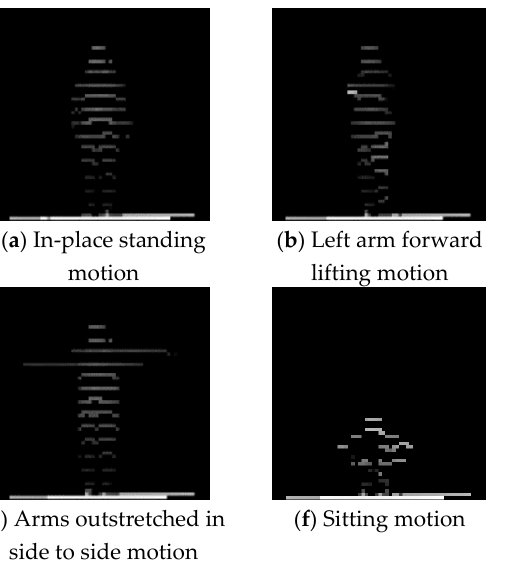
Figure 8. Depth images generated based on voxel.